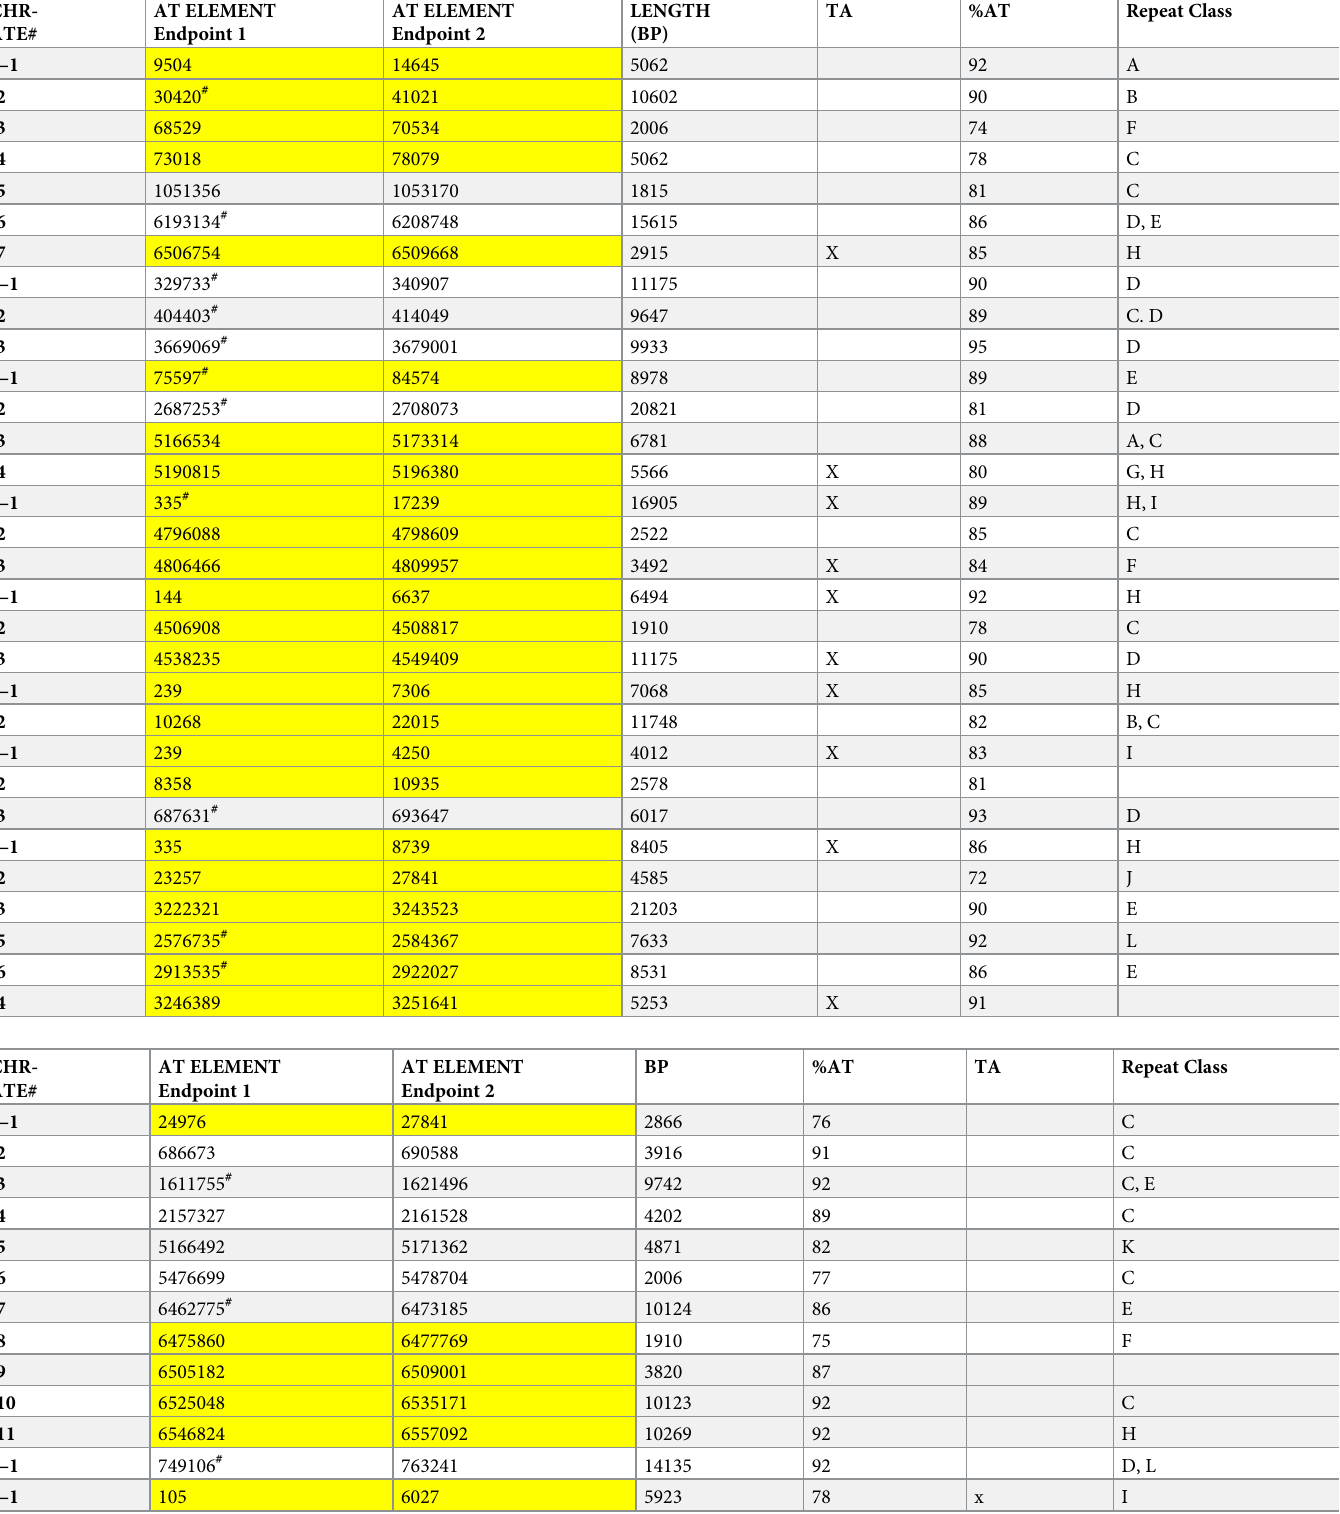
Table 2. A. Approximate positions, lengths, AT contents, and classes of NRRL 3357 ATEs. B. Approximate positions, lengths, AT contents, and classes of CA14 ATEs. C. Approximate positions, lengths, AT contents, and classes of SU-16